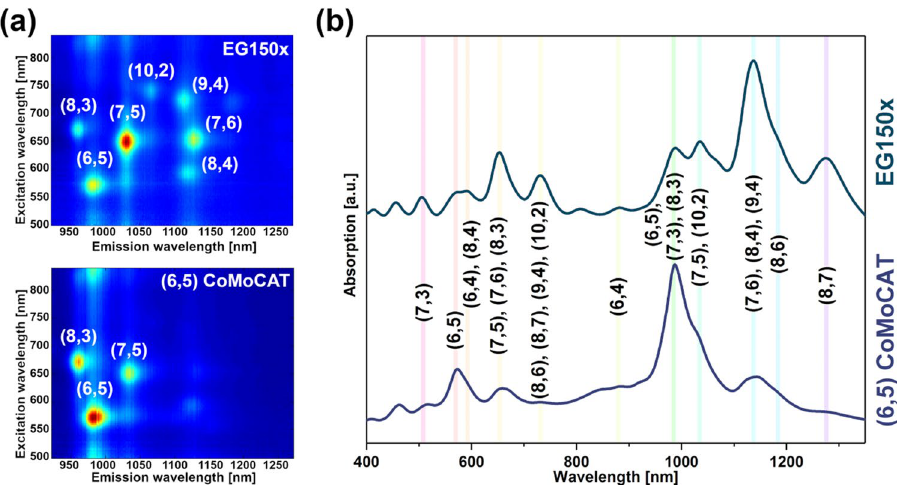
Figure 1. ( a ) 2D PLE maps of unsorted and (6,5)-enriched SWCNT materials dispersed in aqueous SC solution. ( b ) Corresponding optical absorption spectra.